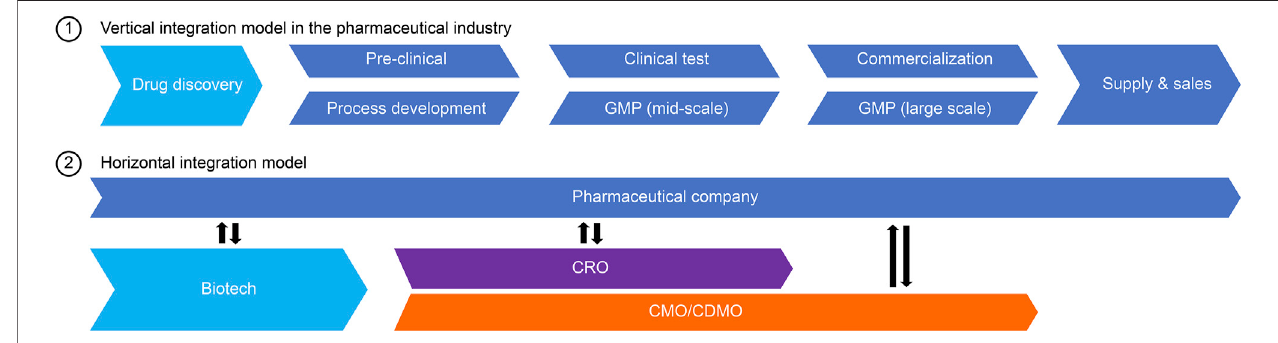
FIGURE 1 | Horizontal division of roles in the pharmaceutical industry.